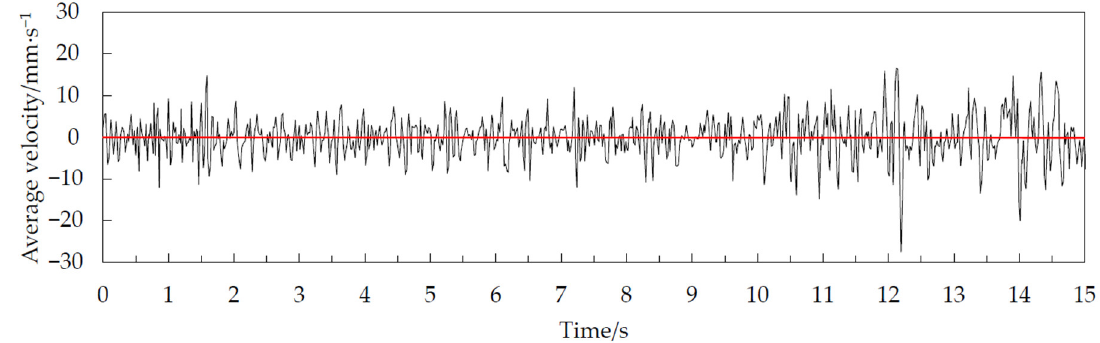
Figure 13. Average velocity of the corn grain in the area below 20 mm on the free surface at a half cone angle of 45° using the central difference method.